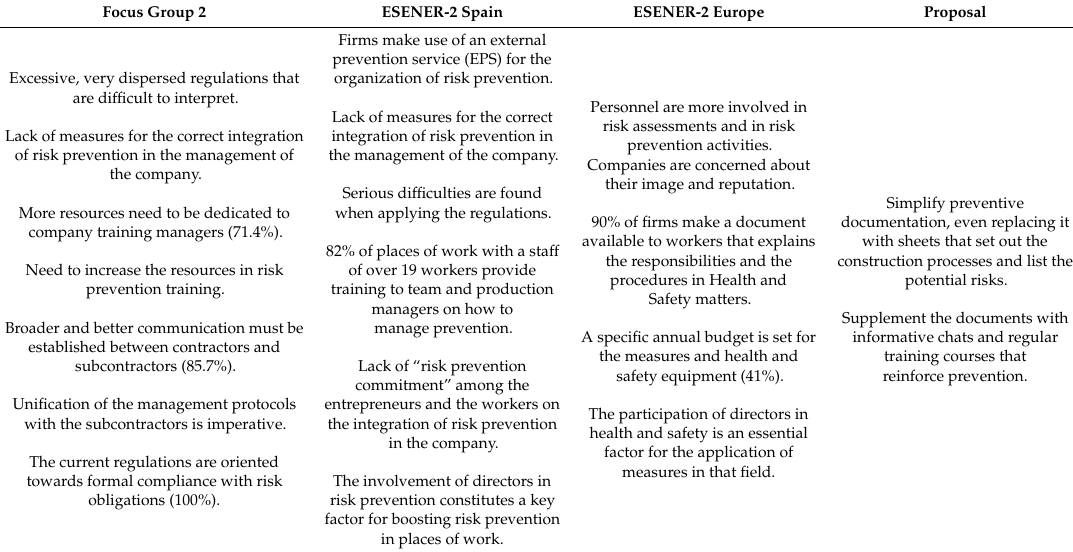
Table 8. Conclusions drawn from focus group 2 and the Second European Survey of Enterprises on New and Emerging Risks (ESENER-2, in both its Spanish and European versions), referring to risk prevention management in construction sector companies. Source: [61,62]. Focus Group 2 ESENER-2 Spain ESENER-2 Europe Proposal Excessive, very dispersed regulations that are di ffi cult to